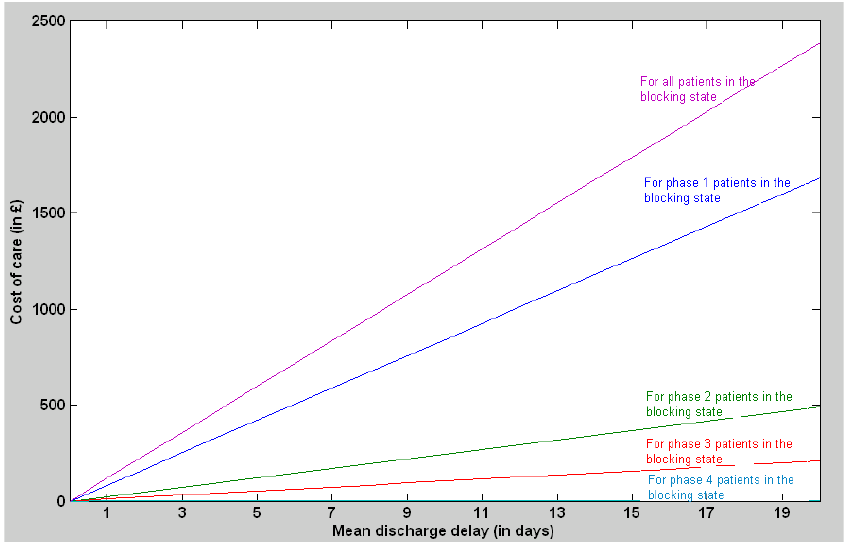
Figure 22. The estimated daily cost of care for patients in the blocking state from each phase expected to be discharged to other destinations (after 1000 days since the first patient gets delayed).